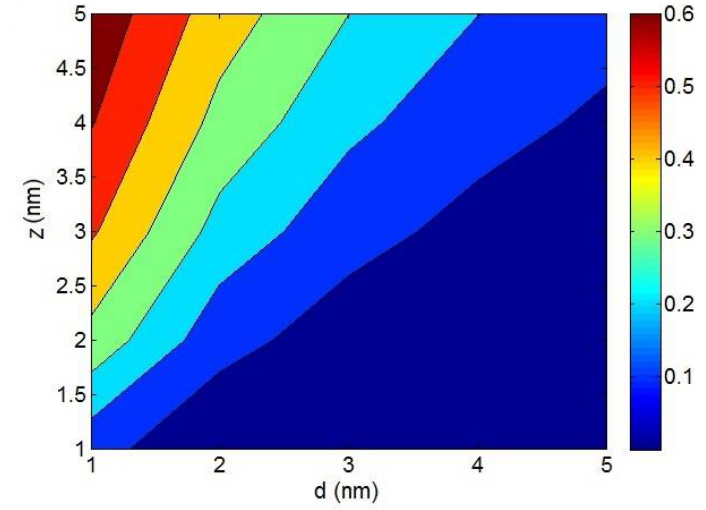
Figure 2. Contour plot for the roles of the d and z parameters in the conductivity of nanocomposites at σ 0 = 1 S/m by Equation (1).